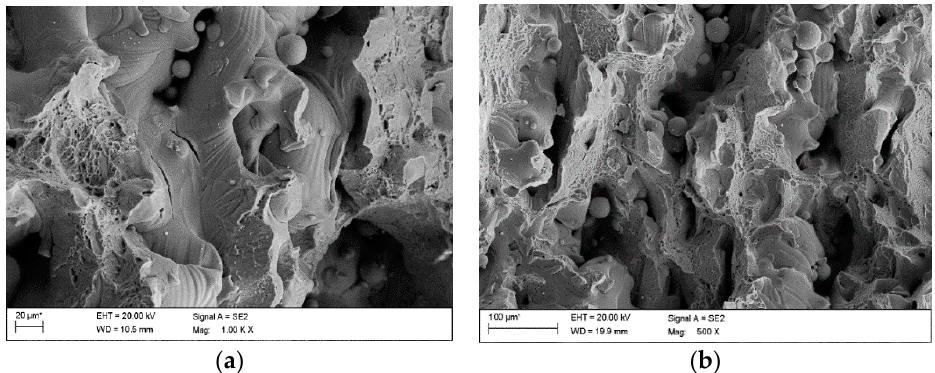
Figure 23. The fracture’s structure of the Ti6Al4V Ti solid 8 alloy after static testing: ( a ) tensile and ( b ) bending.